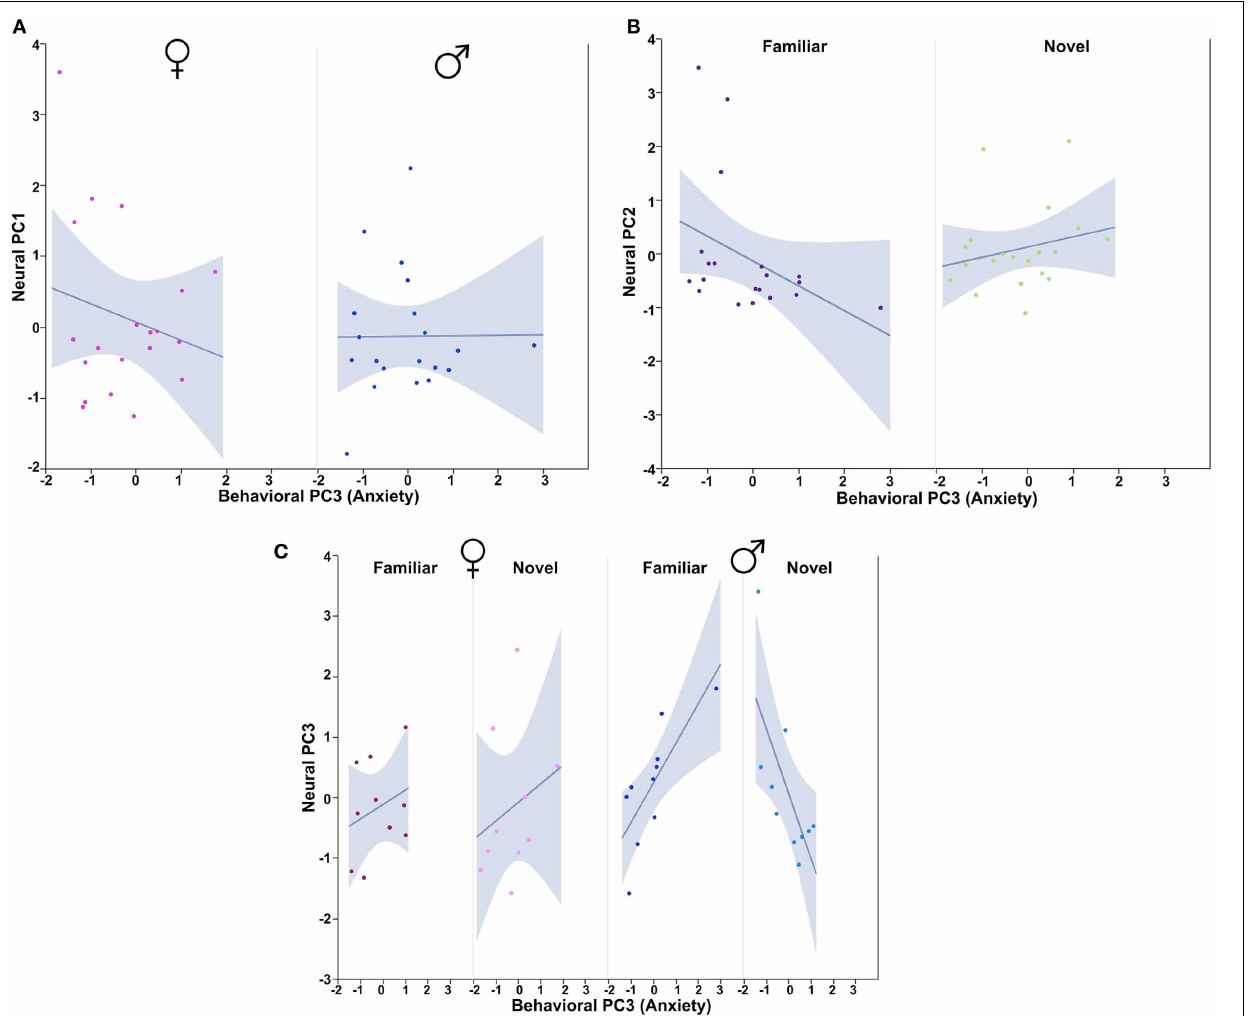
FIGURE 11 | Behavioral PC3 (Anxiety) interacts with Sex and Context to predict multiple Neural PCs. (A) PC3 (Anxiety) tends to correlate negatively with Neural PC1 in females, but not males. Sex × Behavioral PC3 F ( 1 , 32 ) = 4 . 01, p = 0 . 05. (B) Anxiety tends to correlate positively with Neural PC2 in subjects exposed to novel conspecifics, but negatively in subjects